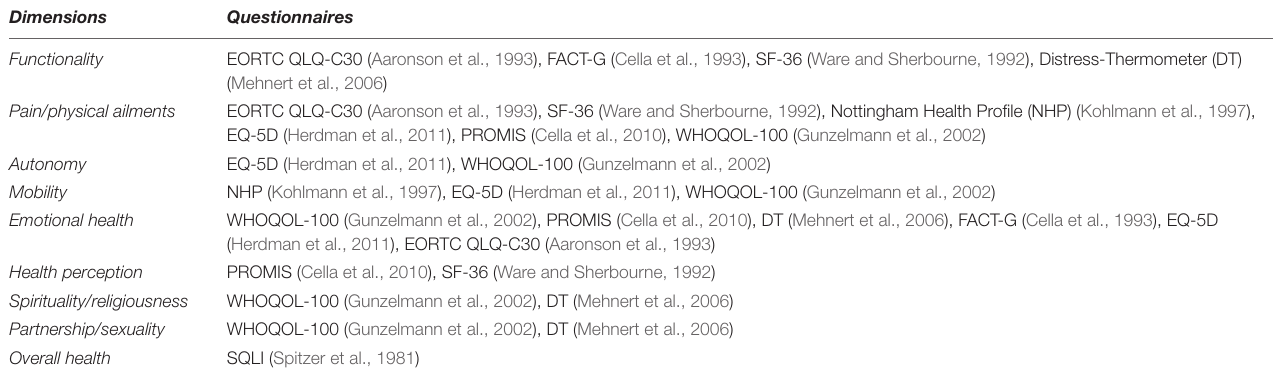
TABLE 1 | Dimensions of HrQoL